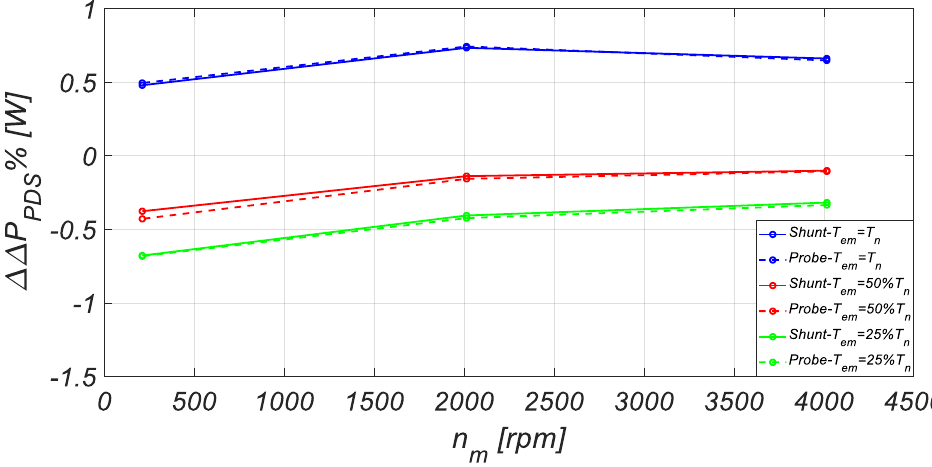
Figure 8. ΔΔ P PDS % as a function of the reference speed for a variation of the d-axis current from I d = 0 A to I d = −1 A and for each of the proposed working condition.